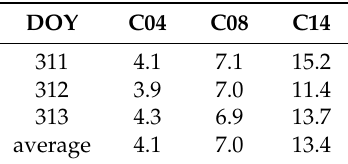
Table 4. Standard deviations of GEO, IGSO and MEO (unit: